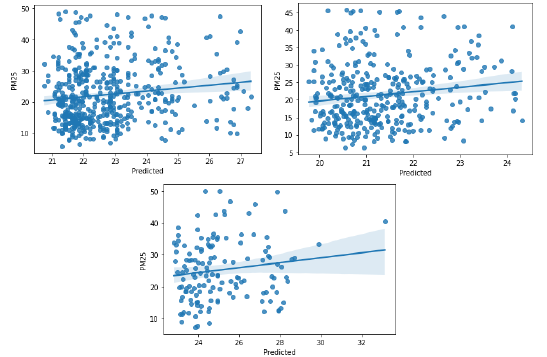
Figure 8. In-situ PM 2.5 vs. Predicted PM 2.5 plots for the yearly model (top left), dry model (top right) and wet model (bottom).